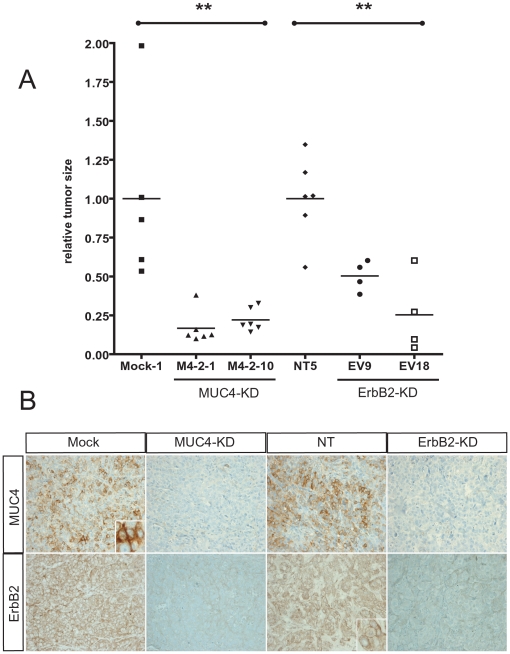
Effect of ErbB2 and MUC4 on tumour growth in vivo.(A) Subcutaneous xenograft of MUC4-KD (M4-2-1 and M4-2-10), ErbB2-KD (EV9 and EV18) and control (Mock-1 and NT5) cells were performed in six SCID mice. Relative tumour size was determined at day 22. (B) IHC analysis of MUC4 and ErbB2 expression was analysed on extracted tumours. MUC4 is expressed at the membrane surface and within the cytoplasm in Mock cells (insert). ErbB2 is expressed at the membrane surface in NT control cells (insert).